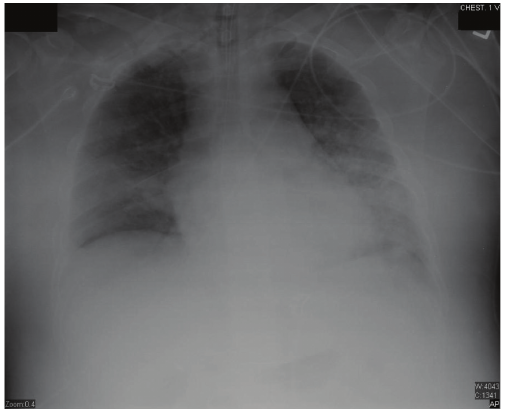
Figure 4: Chest X-ray day 31 after chemotherapy (ANC was 6700 cell/ µ